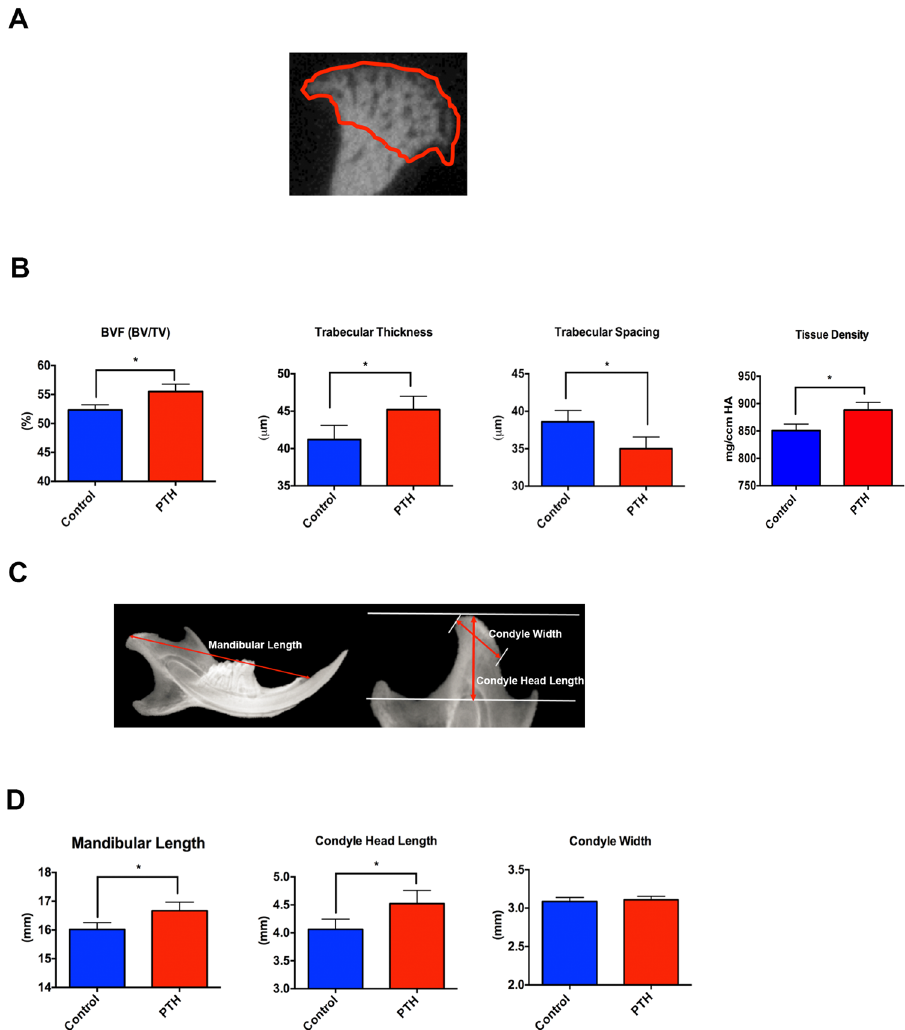
Figure 2. Increased bone volume, trabecular thickness and mandibular length in the I-PTH injected mice. ( A ) Region of interest for measurement of bone volume fraction, tissue density, trabecular thickness and trabecular spacing. ( B ) Histograms showing the significant increase (p < 0.05) in bone volume fraction (BVF; n = 6; CI for control group: 51.9–53.45; CI for I-PTH group: 53.89–57.11) trabecular thickness (n = 6; CI for control